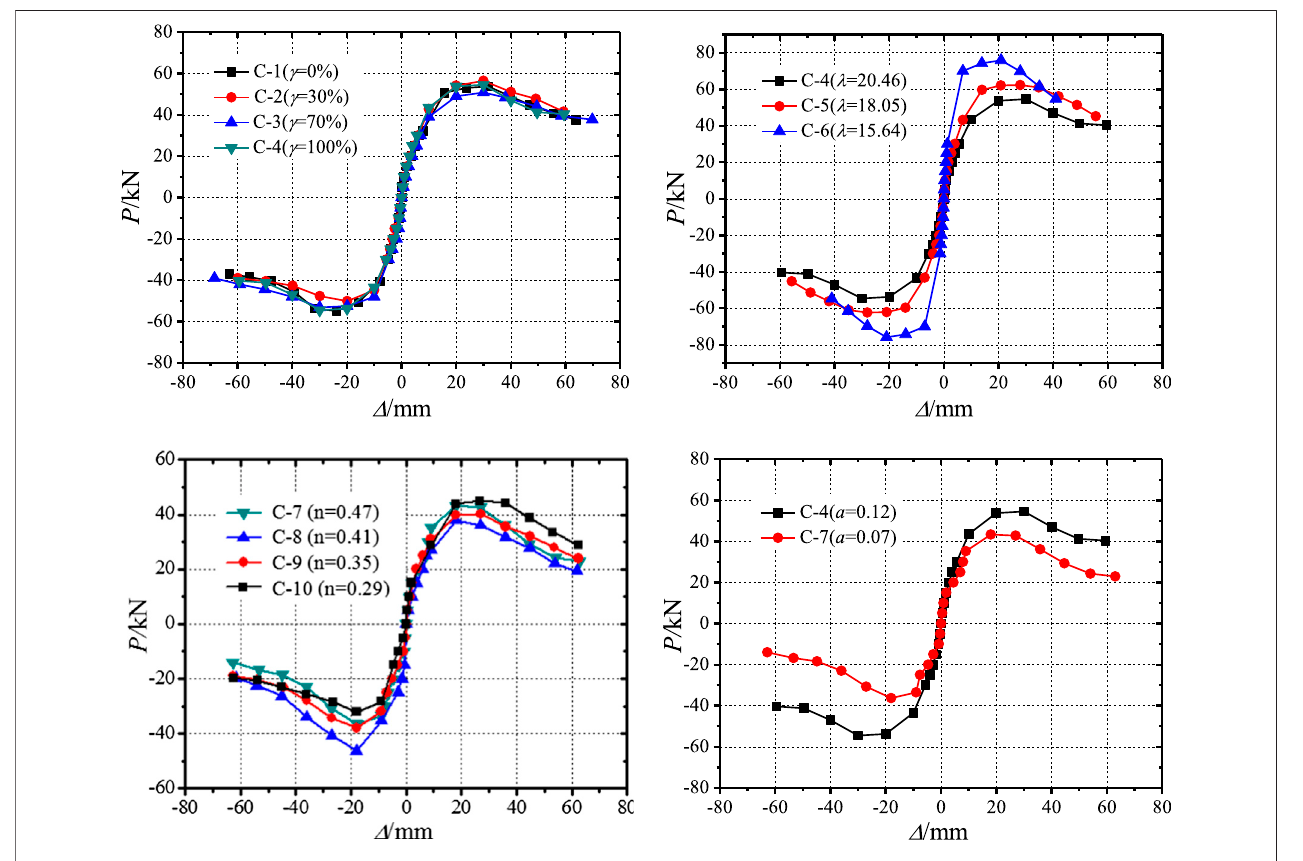
FIGURE 7 | Skeleton curve of RCFST